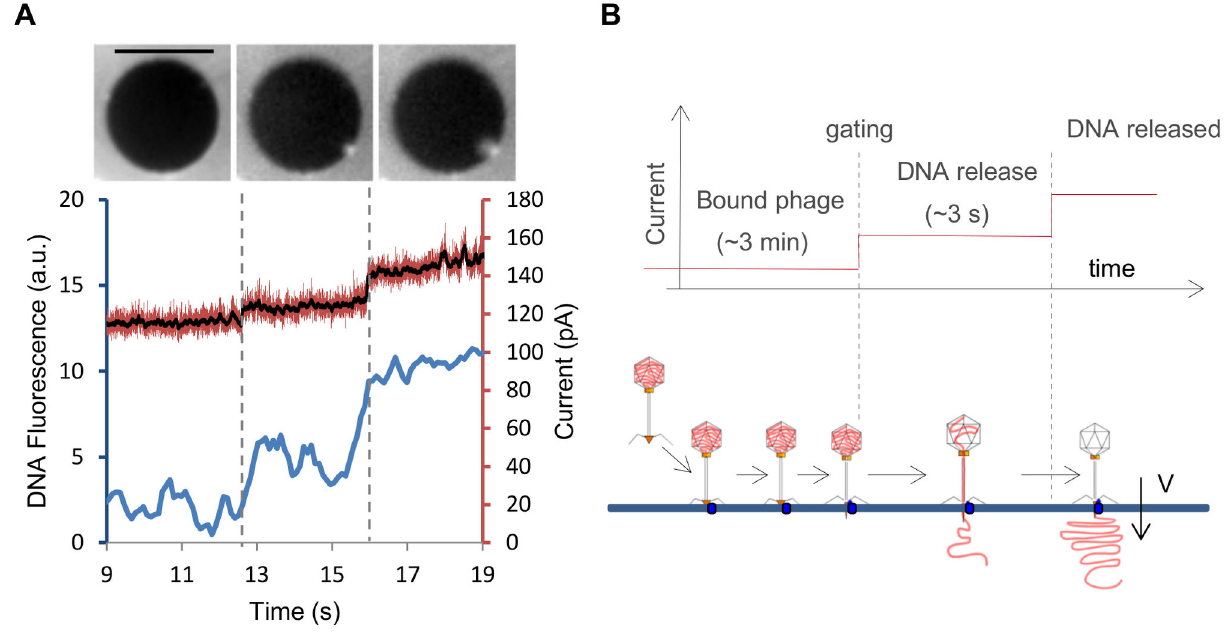
Figure 6. Simultaneous monitoring of T5 DNA release and phage induced pore formation through the lipid membrane. A\ Simultaneous recording of electrophysiological activity of the phage induced pore and fluorescence image of released DNA. Three phases are visible. Left (t < 12.5 s): the DNA has not been released. Middle (12.5 s < t < 16 s): fluorescence increase period i.e. DNA release step. Right (t > 16 s): fluorescence plateau reached, the DNA has been completely released. Top: mean of Yo-Pro I fluorescence images obtained for the three periods. Unstained phages were used. Hence Yo-Pro I stains only the DNA released from phages, and not the intracapsid DNA. Bottom: the amount of fluorescence increase is quantified and shown over time (blue curve). Simultaneous current measurement is shown in red (black: mean current). Two current steps flank the beginning and the end of the fluorescence increase period. Applied voltage = -20 mV. Scale bar: 10 μm. B\ Suggested sequence of events leading to phage DNA ejection. See discussion for details.